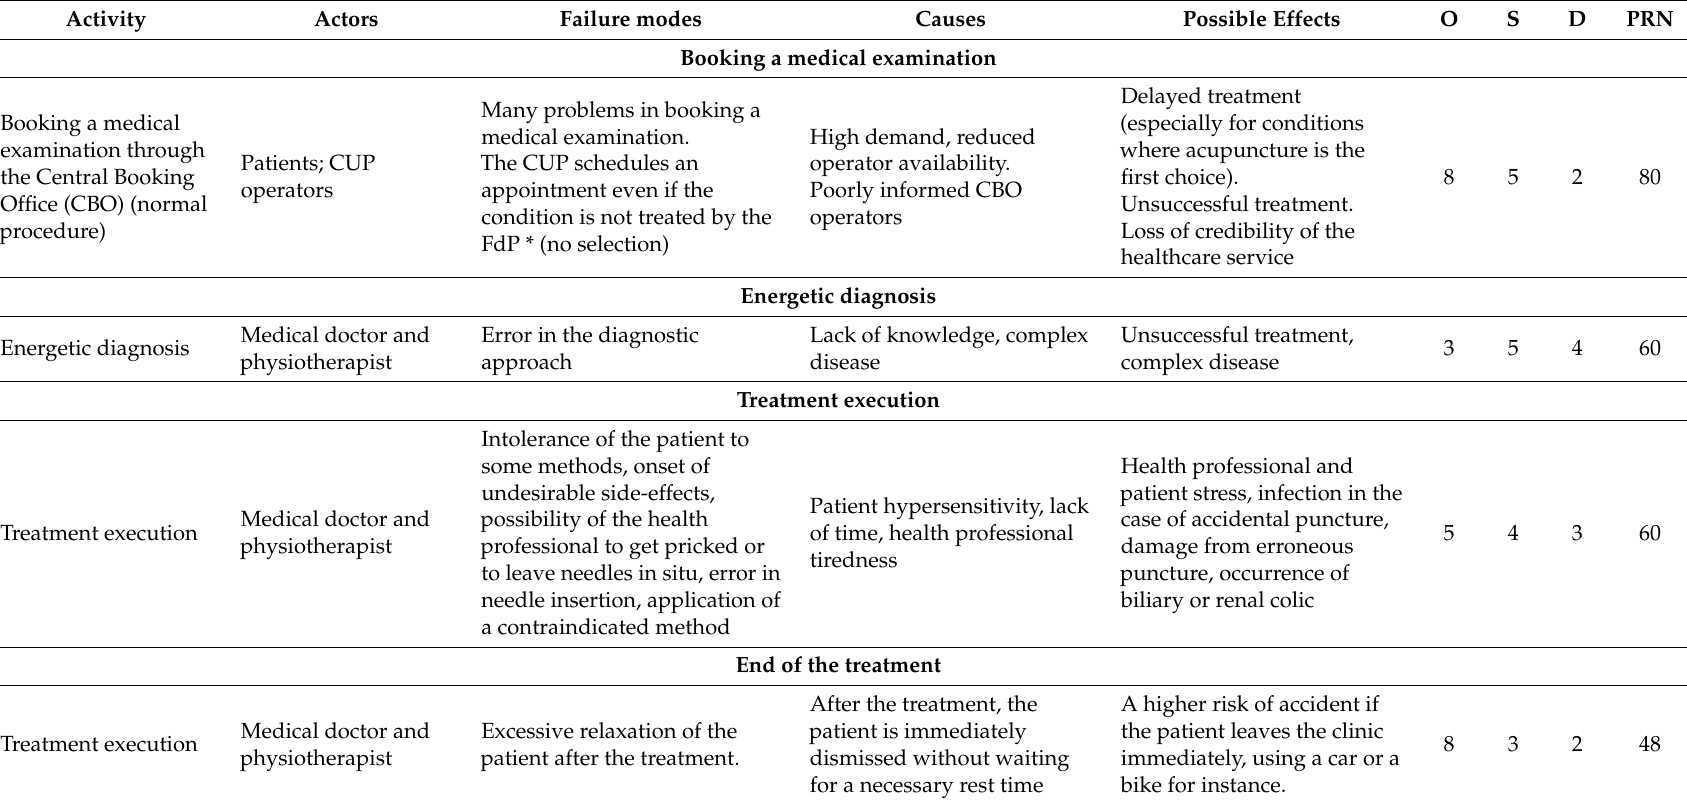
Table 5. Example of FMEA application and RPN value calculation in the diagnostic–therapeutic pathway of the Acupuncture and Traditional Chinese Medicine Clinic “Fior di Prugna” (FdP) of